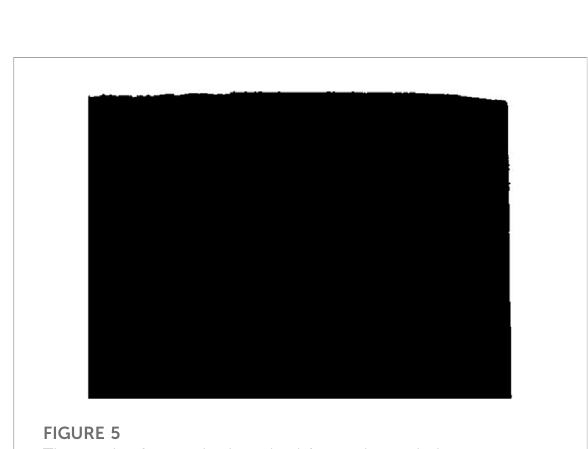
FIGURE 5 The result of watershed method for coal sample image.